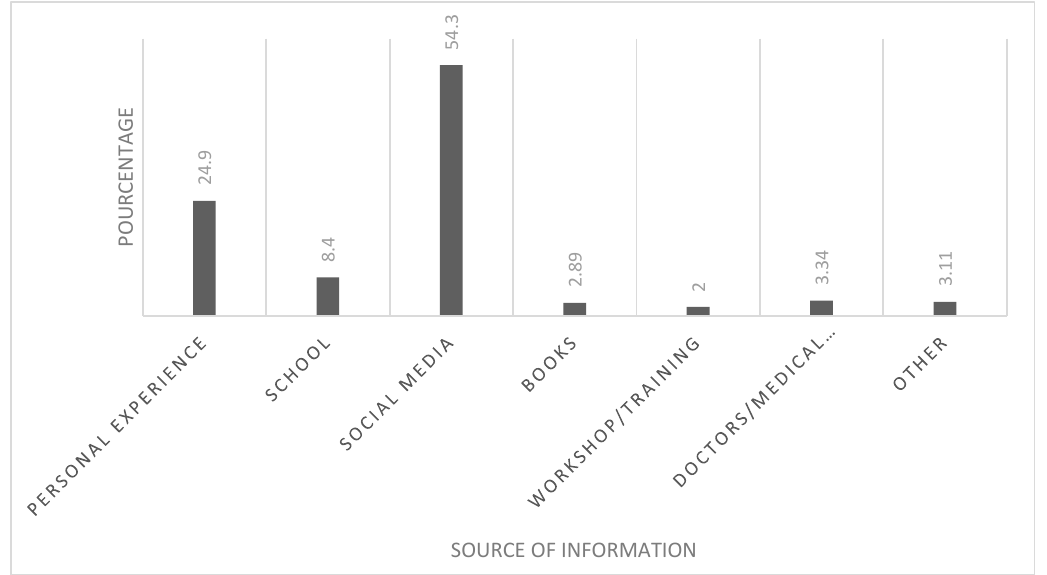
Figure 1. Participants’ sources of information about ASD.